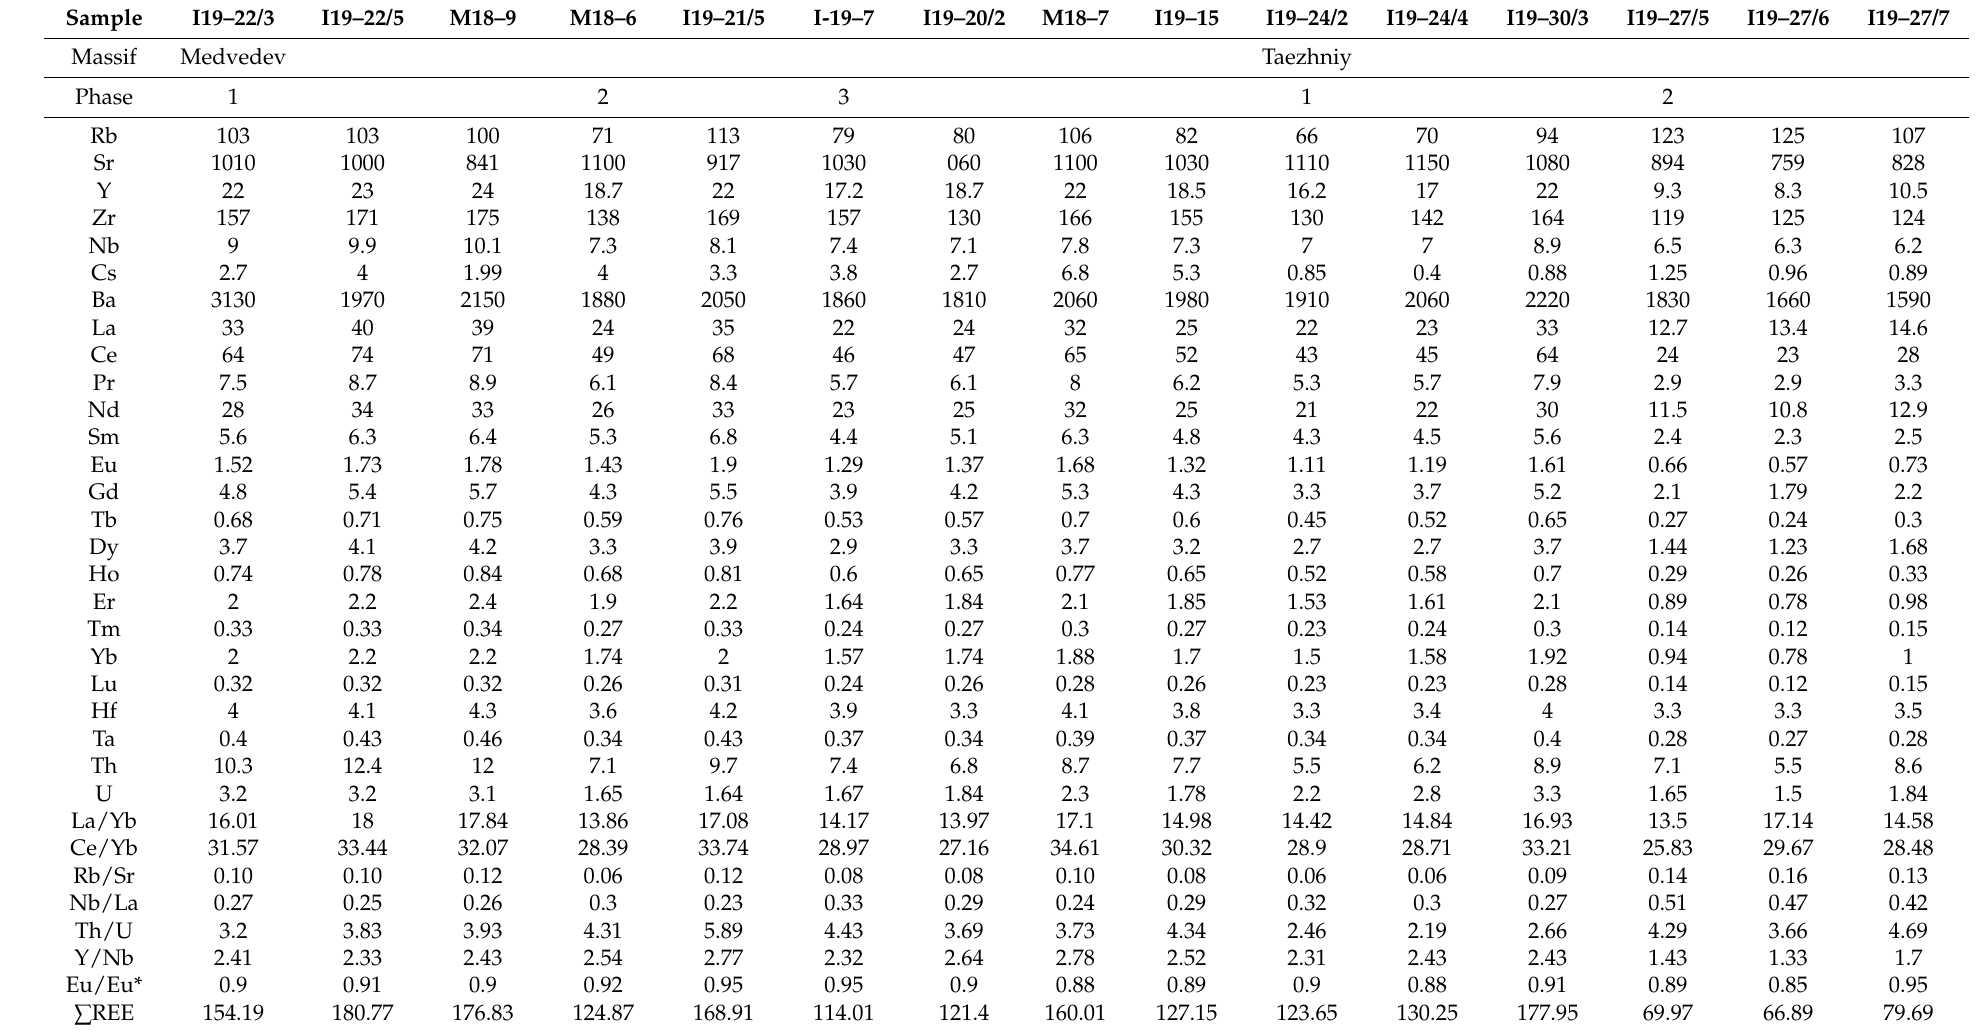
Table A3. Geochemical composition of the igneous rocks of Medvedev and Taezhniy massifs according to ICP-MS data (all values in